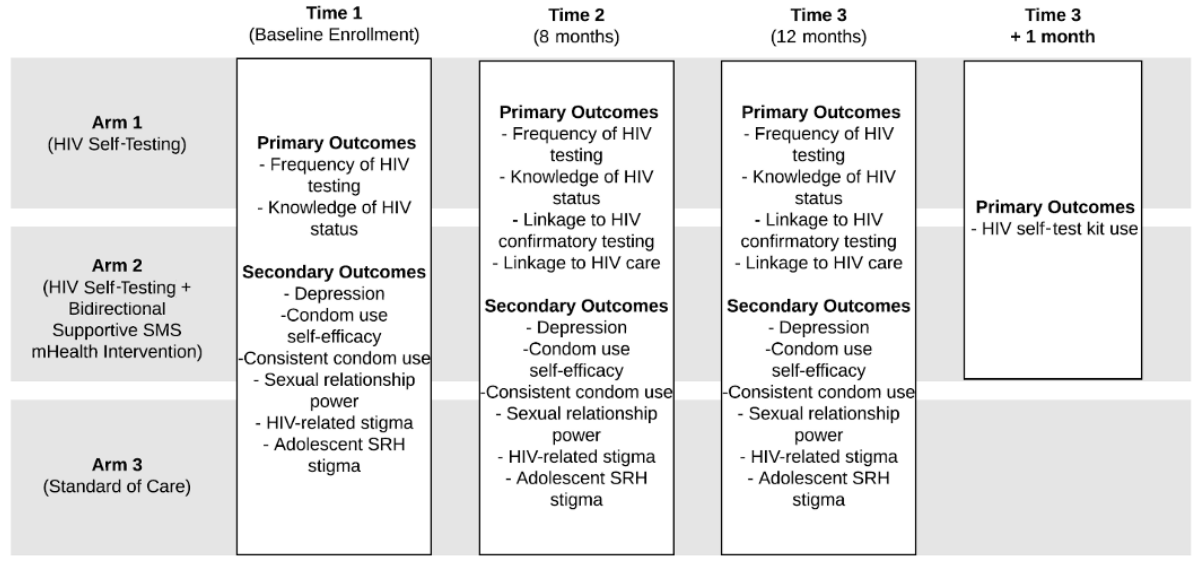
Figure 1. Study design for Tushirikiane, a cluster randomized trial of a mobile health (mHealth) HIV self-testing strategy among urban refugee and displaced youth in Kampala, Uganda. SRH: sexual and reproductive